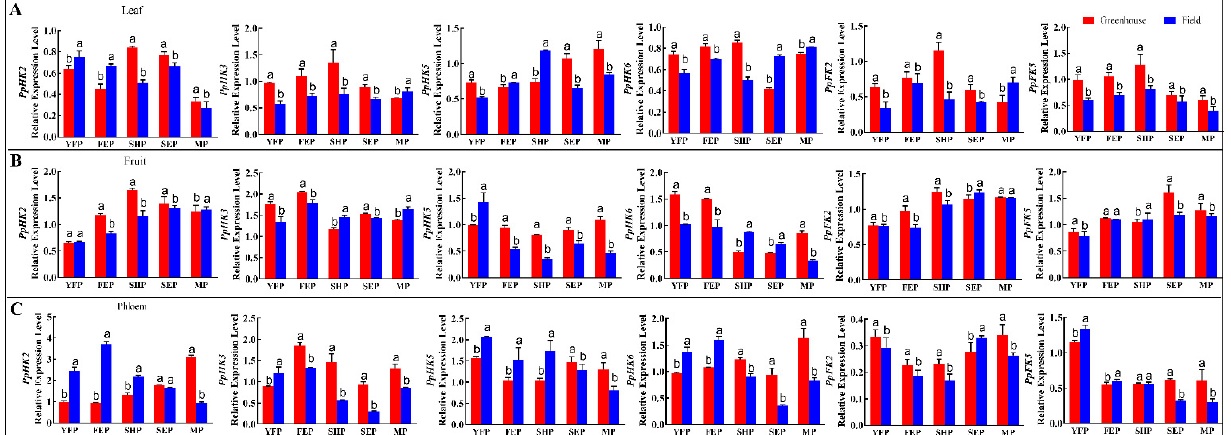
Figure 11. Expression levels of genes related to hexose metabolism in different parts of peach trees grown in the field and greenhouse. ( A – C ) show the expression levels of hexose metabolism-related genes in leaves, fruits and phloem, respectively. The data are presented as the means ± SDs from three biological replicates. Different lowercase letters indicate significant differences ( p <